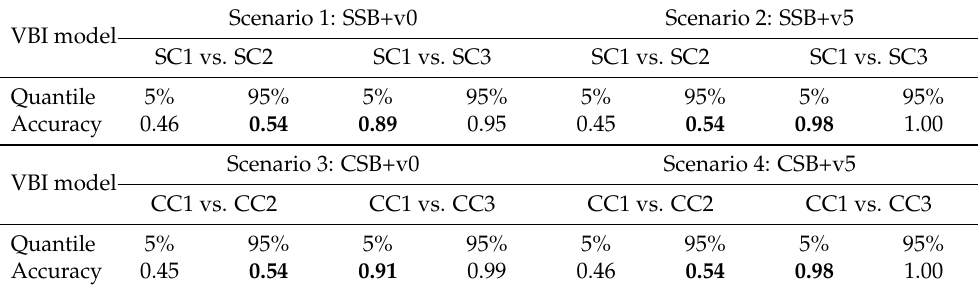
Table 10. Quantiles of accuracy values using MFCCs.